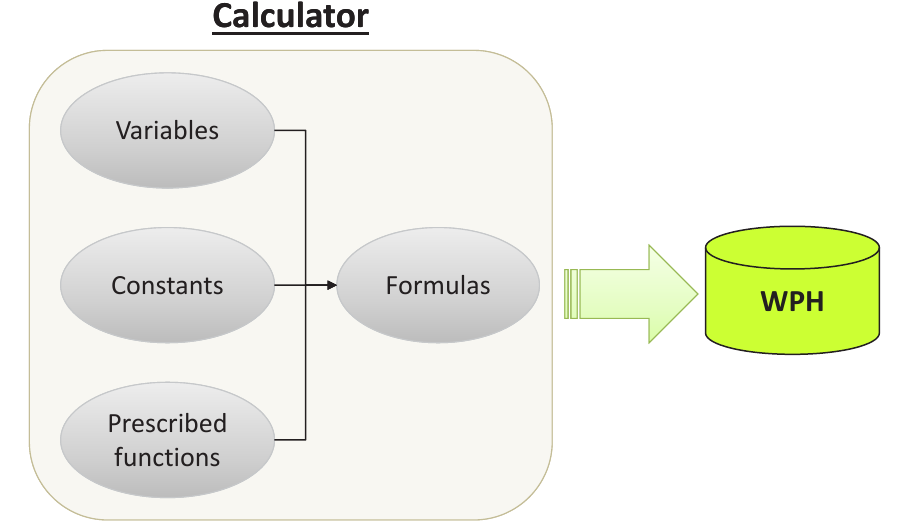
Figure 9. The basic structure of the calculator